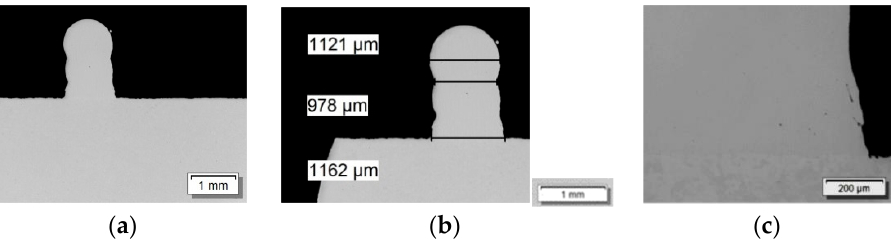
Figure 4. Cross section of multilayer build-up: ( a ) overview; ( b ) structure width; ( c ) detailed view of the defect free transition area.